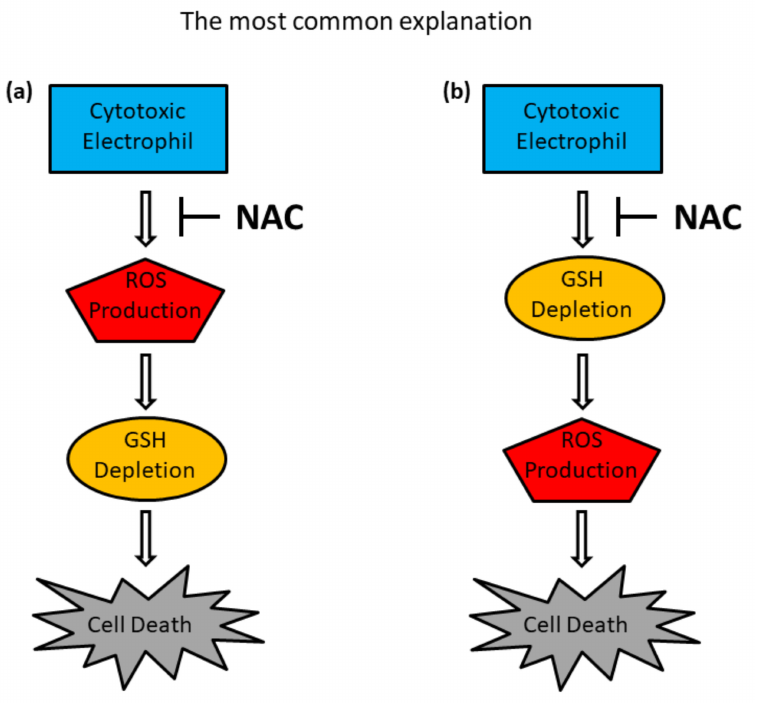
Figure 2. Schematic for putative NAC protection pathways. Cytotoxic effects of an electrophilic agent are accompanied by ROS production, GSH depletion, and eventually result in cell death. Panel ( a ) NAC prevents all adverse effects including cell death by direct scavenging of the ROS. Panel ( b ) NAC prevents all adverse effects including cell death by GSH repletion, i.e., indirect ROS